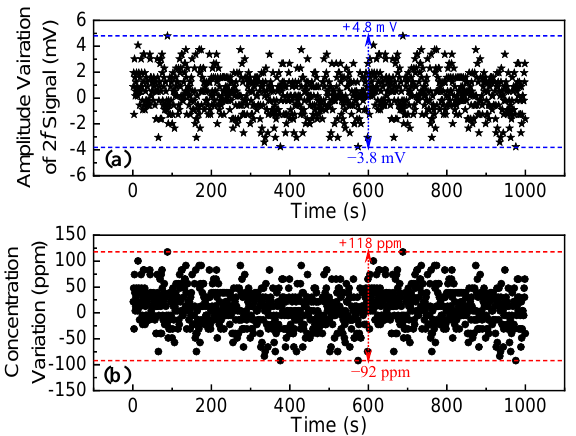
Figure 8. Stability test of the system by obtaining the harmonic signal from − 3.8 to 4.8 mV shown as stars ( a ). Gas concentration fluctuation calculation can be obtained by calculations from − 92 to 118 ppm shown as stars ( b ).